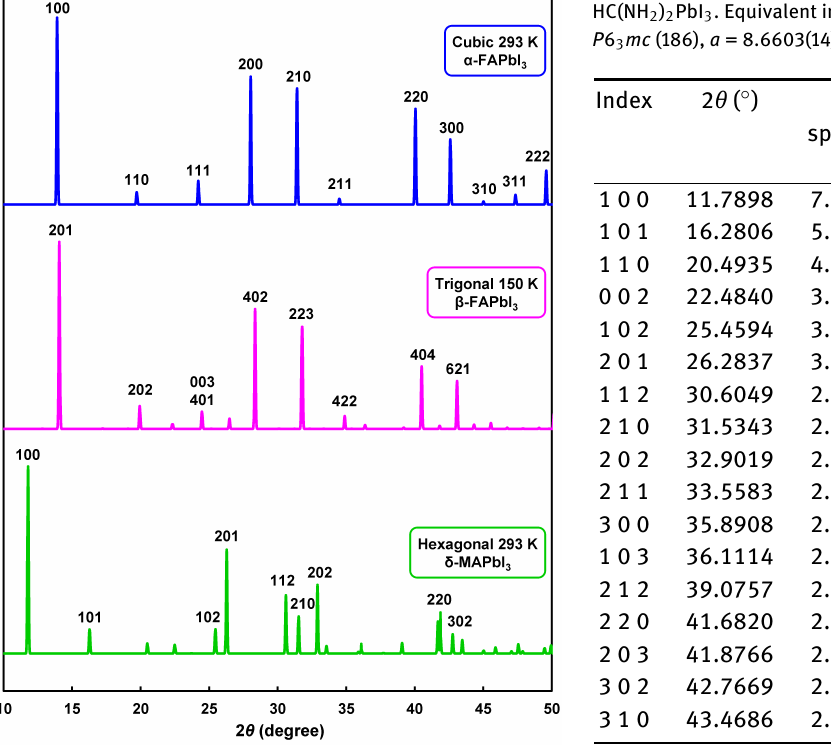
Table 10: Calculated X-ray diffraction parameters of hexagonal δ - HC(NH 2 ) 2 PbI 3 . Equivalent indices were combined. For space